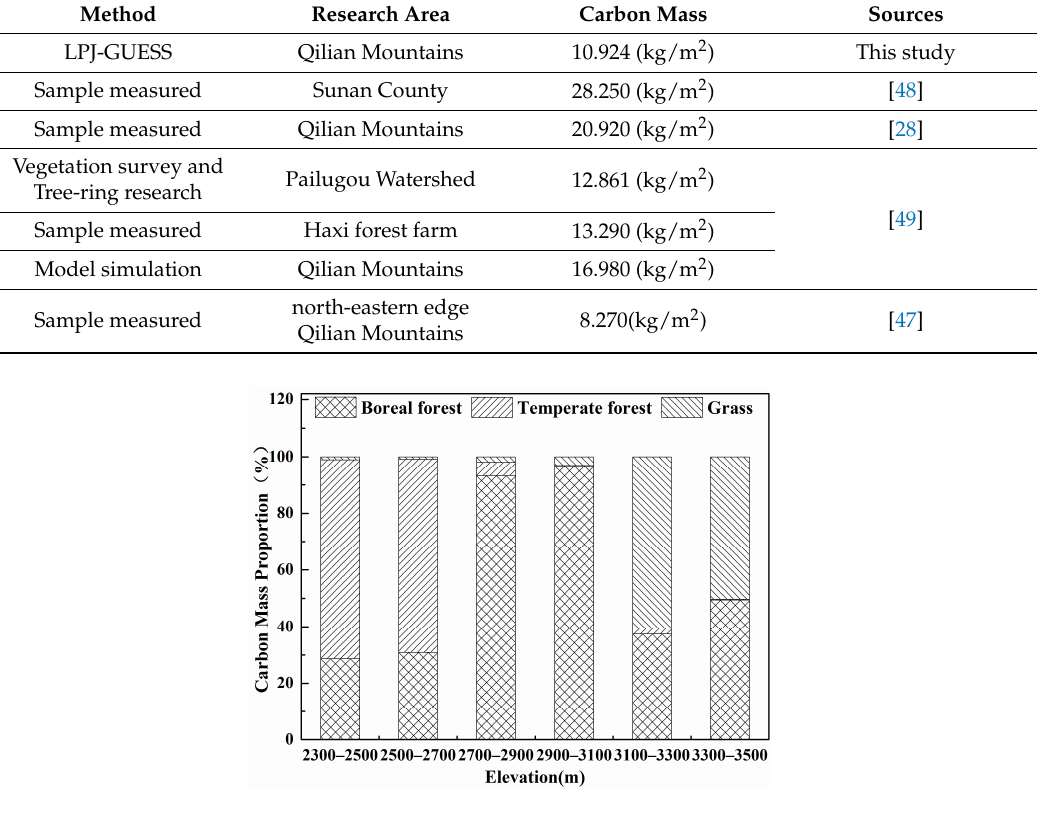
Figure 2. Carbon mass proportion at different elevations for twelve meteorological stations. Data are the means of simulated values for each range in elevation.